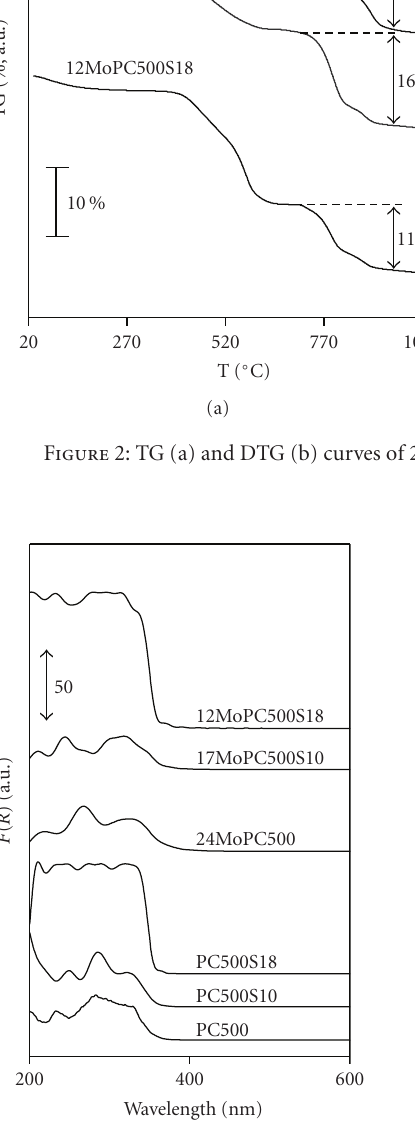
Figure 3: UV-Vis DRS spectra of PC500, PC500S10, PC500S18, 24MoPC500, 17MoPC500S10, and 12MoPC500S18